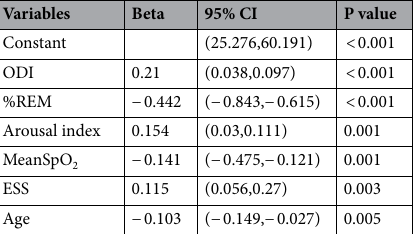
Table 3. Model for the prediction of change in REM sleep. CI confidence interval, ESS Epworth sleepiness score, ODI oxygen desaturation index, SpO 2 pulse oxygen saturation, REM% percentages of rapid eye movement sleep.